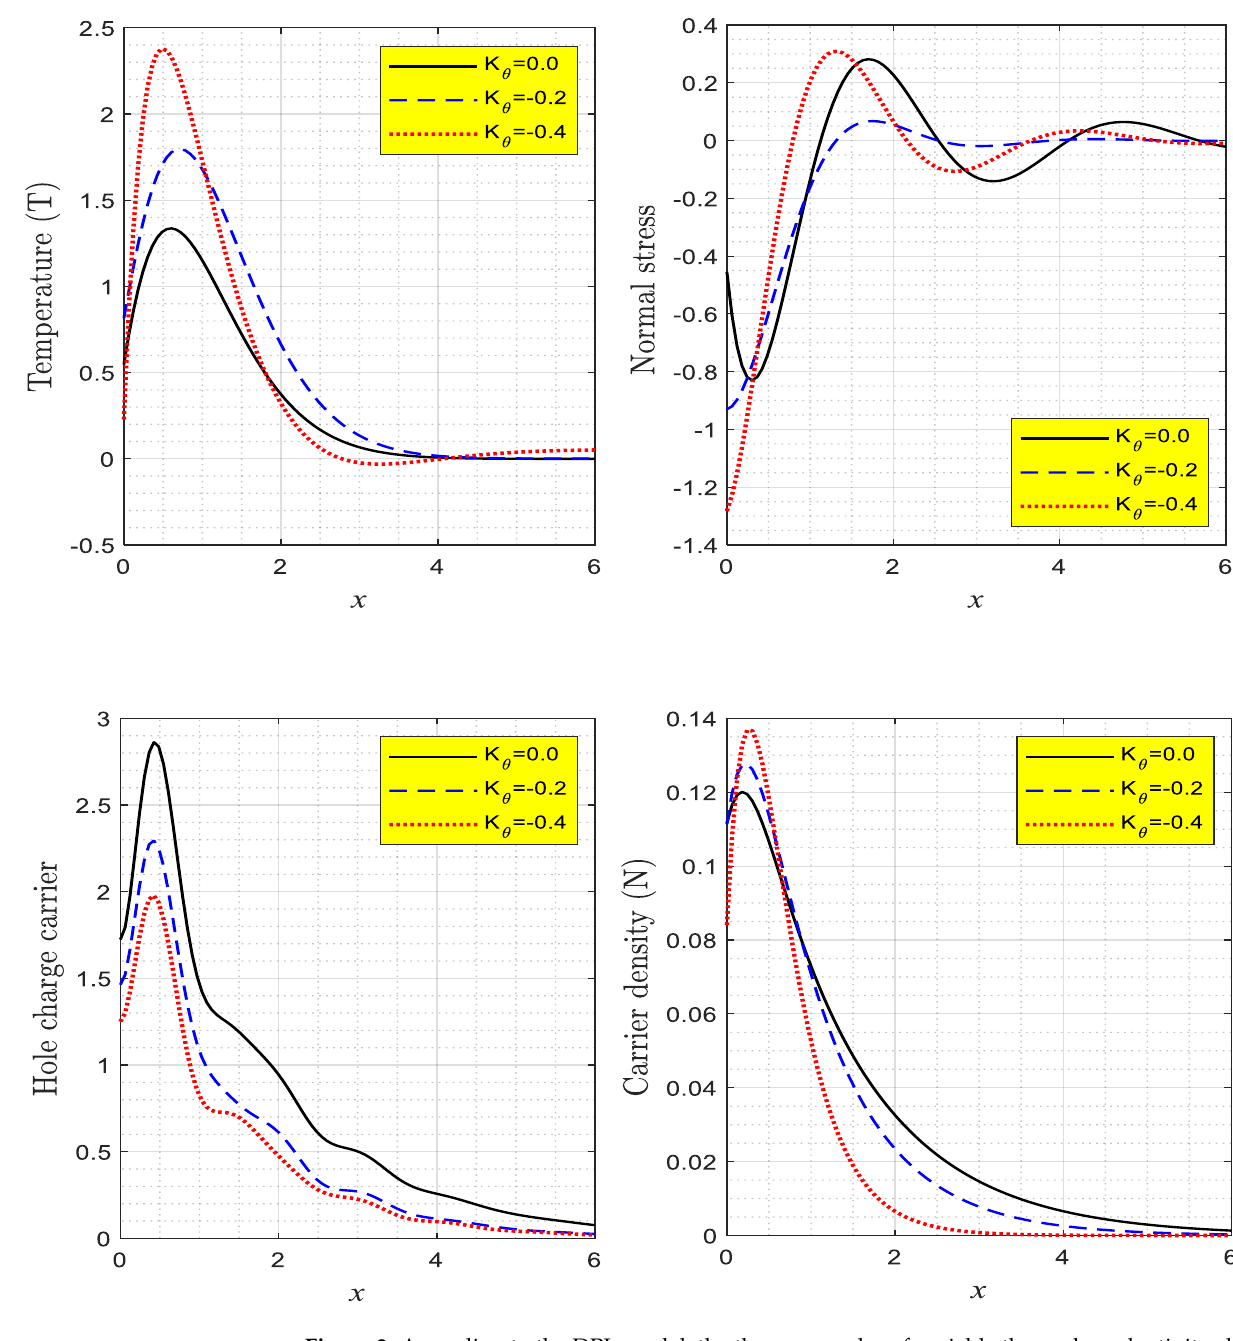
Figure 3. According to the DPL model, the three examples of variable thermal conductivity show a variance in the non-local physical field distributions as a function of axial distance.